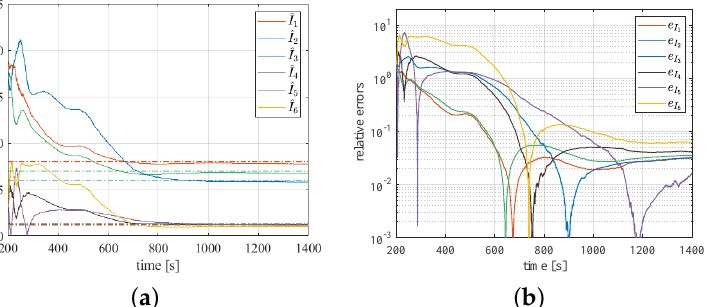
Figure 8. The estimations of the inertial parameters of the object after the collision: ( a ) errors of the estimations of the moment of inertia; ( b ) errors of the estimations of the product of